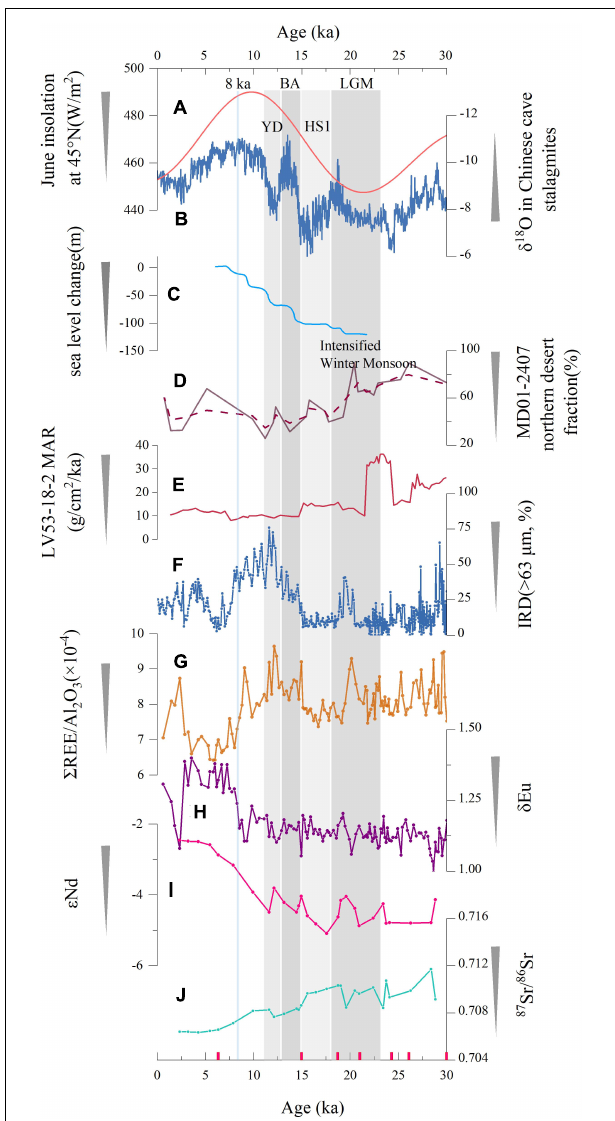
FIGURE 10 | Comparison of global and regional records during the last glacial period. June insolation at 45 ◦ N (A) (Berger and Loutre, 1991), Chinese speleothem δ 18 O (B) (Cheng et al., 2016), sea level curve of China Seas (C) (Liu et al., 2004), dust fraction of Gobi-Northeast China desert in core MD01-2407 (D) (Nagashima et al., 2007a), REEs mass accumulation rates (E) , sea ice indicator (F) (Dou et al., 2020), REEs/Al 2 O 3 ratio (G) , Eu anomaly curve (H) , radiogenic isotopes record in core LV53-18-2 (I,J) . LGM, the Last Glaciation Maximum; H1, the Heinrich stadial 1 cold event; B/A, the Bølling–Allerød warming event; YD, the Younger Dryas cold event. Red rectangles denote age control